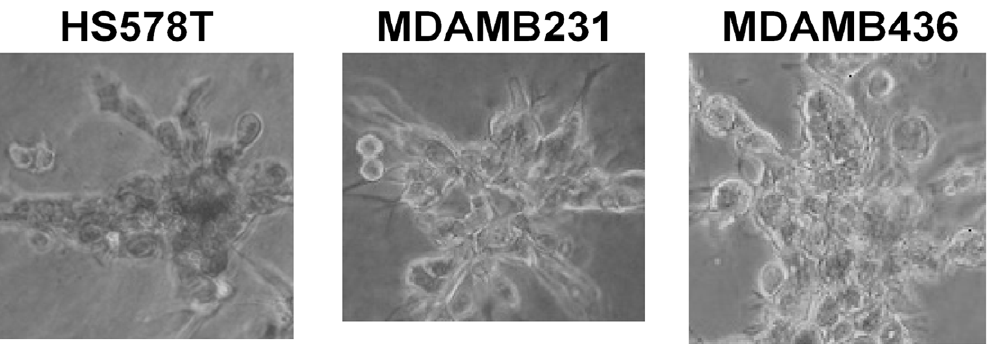
Figure 4. Three cell lines displaying aggressive phenotypes are discovered with n ~ 2 . All other cell lines are grouped in a different subpopulation.